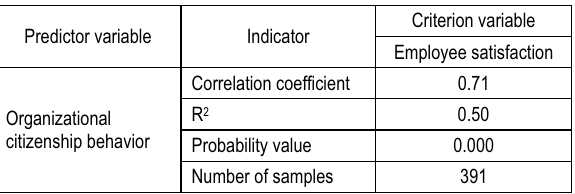
Table 6. The relationship between organizational citizenship behavior and organizational